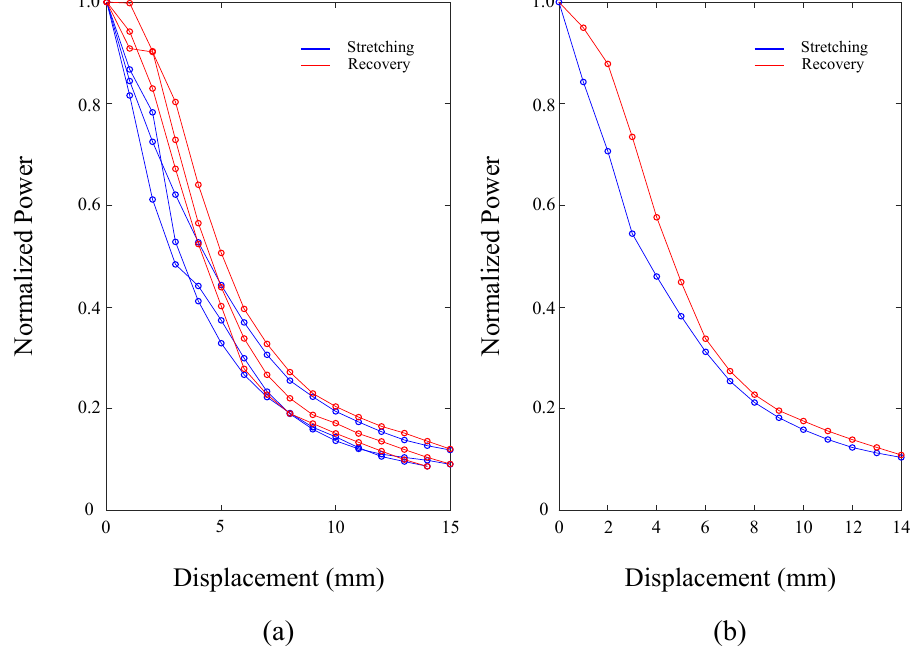
Figure 10. Results of experiment tests carried out with the elastic tendon. ( a ) Curves of normalized power vs. displacement for three tests performed with different tendons of the same characteristics. Blue lines, stretching phase; red, recovery phase. ( b ) Average behavior of the three experiments for both phases; stretching (blue) and recovery (red). Hysteresis is